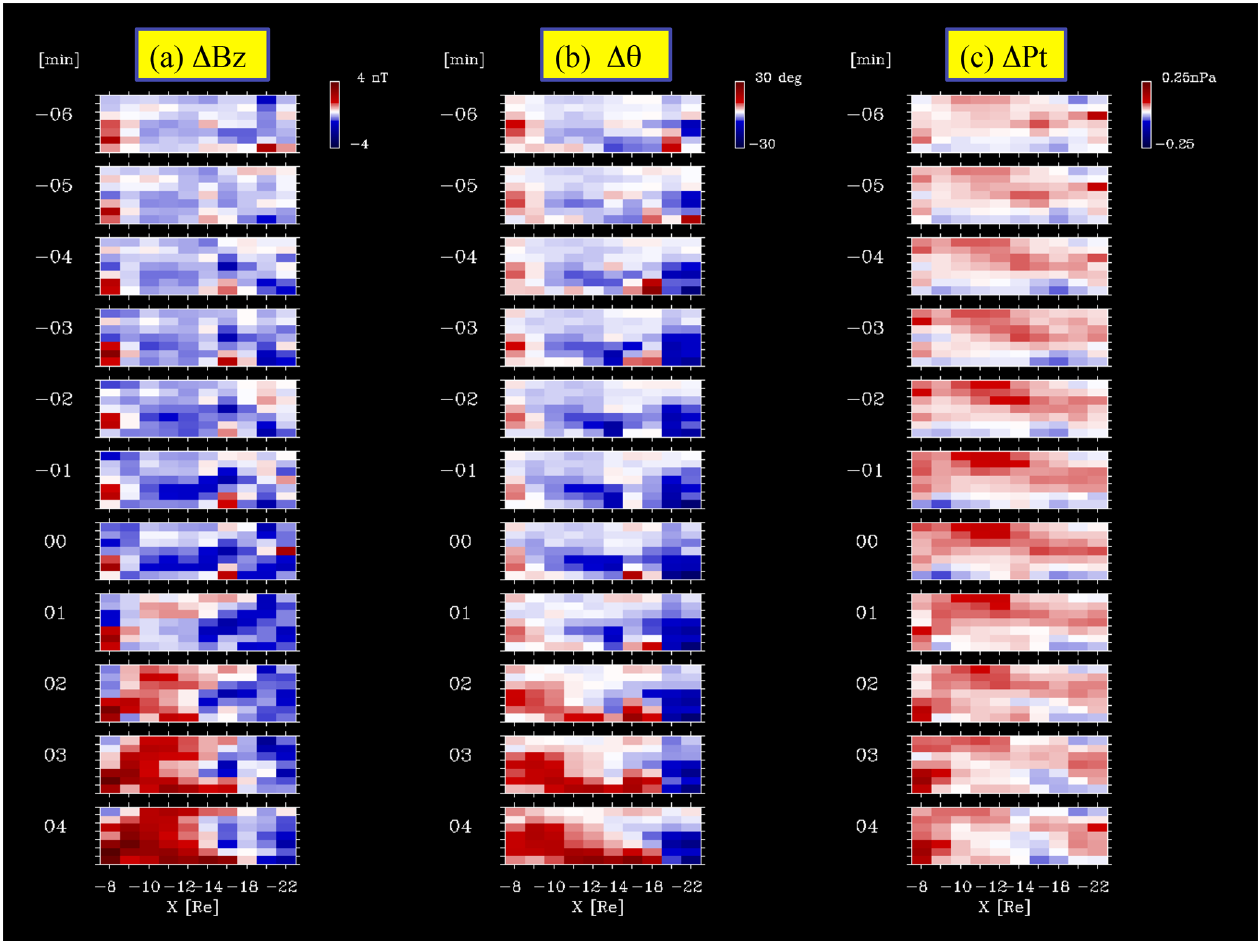
Fig. 4. Meridional displays of the deviations of (a) the northward magnetic field, 1B Z ; (b) the elevation angle, 1θ ; and (c) the total pressure, 1P t , with respect to the relevant average values representative of the interval from t =− 12min to t =−